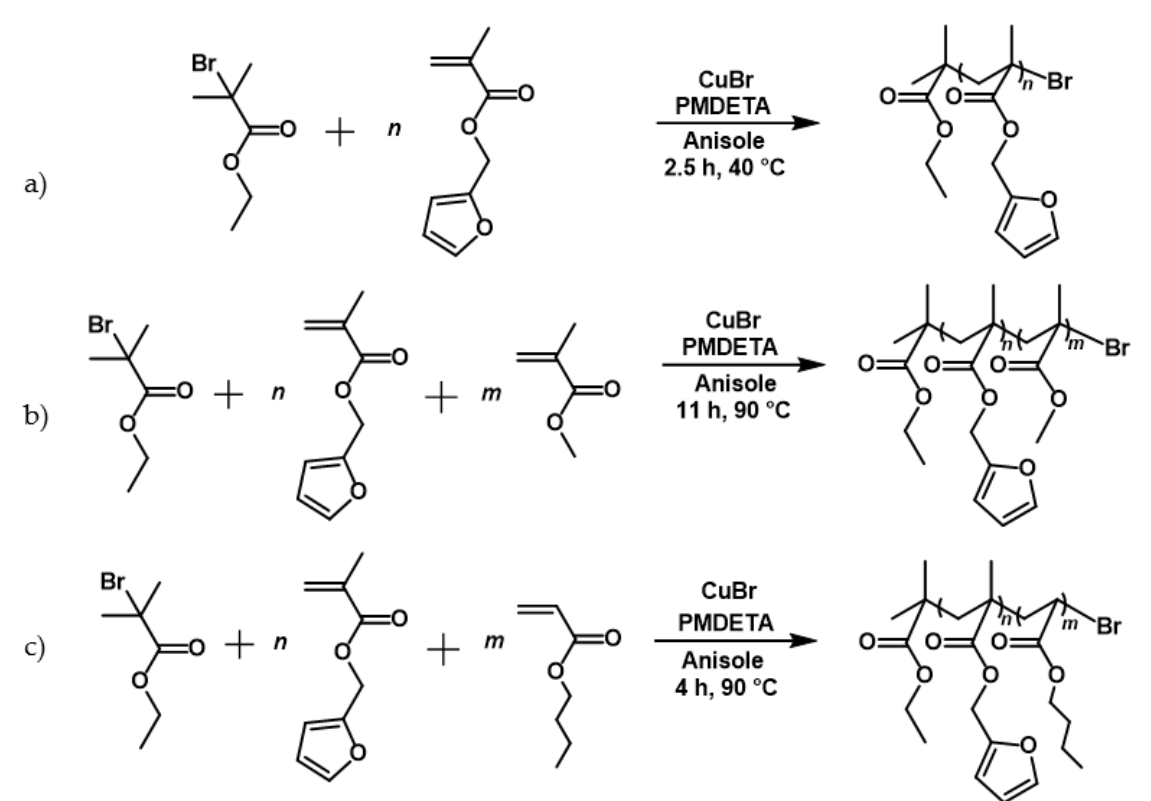
Figure 5. Reaction scheme of: ( a ) the homo-polymerization of furfuryl methacrylate. Atom transfer radical polymerization (ATRP) conditions: monomer:initiator:catalyst:ligand is 50:1:0.3:0.3 in 70 wt% anisole. ( b ) The copolymerization of methyl methacrylate and furfuryl methacrylate. ATRP conditions: monomer:initiator:catalyst:ligand is 100:1:1:1 in 50 wt% anisole and ( c ) the copolymerization of butyl acrylate and furfuryl methacrylate. ATRP conditions: monomer:initiator:catalyst:ligand is 100:1:1:1 in 50 wt% anisole.